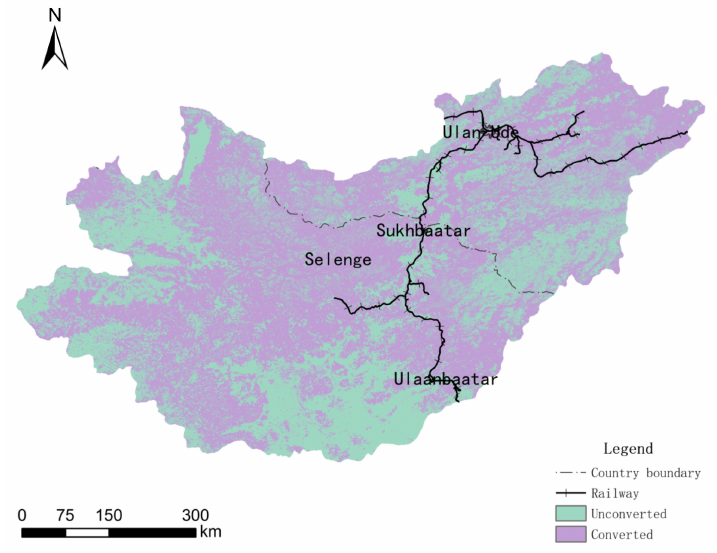
Figure 14. Distribution of transformed/untransformed plots in 1992–2015.